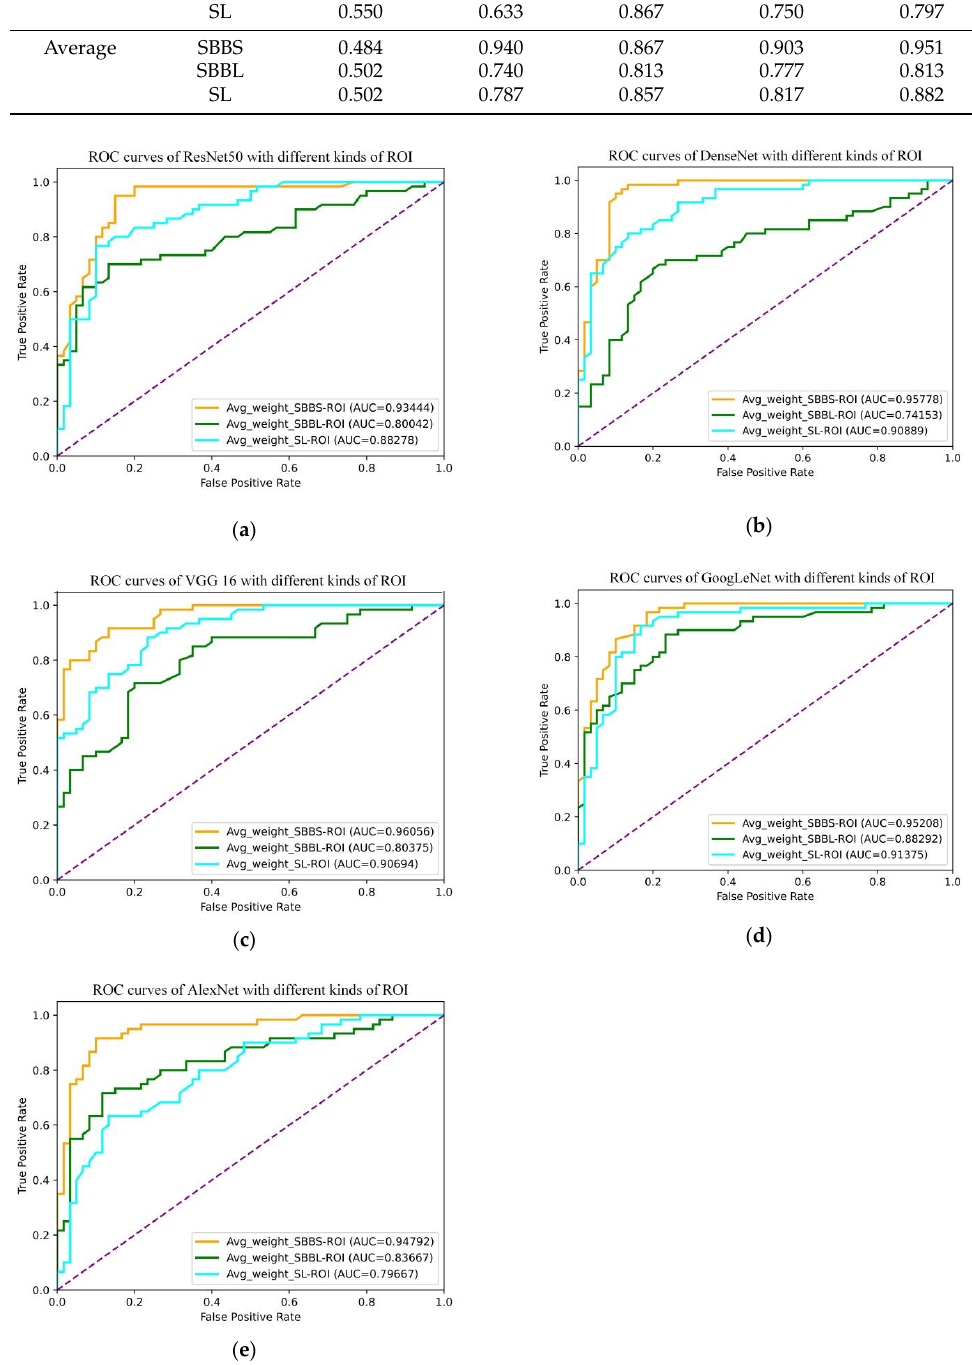
Figure 4. Lesion-level receiver operating characteristic (ROC) curves and AUC value of DCNNs with three kinds of ROI and average weighting method. ( a ) ResNet50. ( b ) DenseNet. ( c ) VGG16. ( d ) GoogLeNet. ( e ) AlexNet.